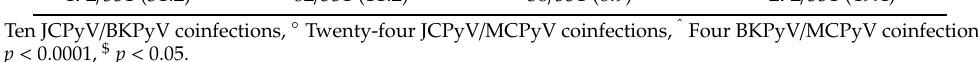
Table 4. HPyVs prevalence in urinary samples collected from kidney transplant donors and recipients. JCPyV +/ tot (%) BKPyV +/ tot